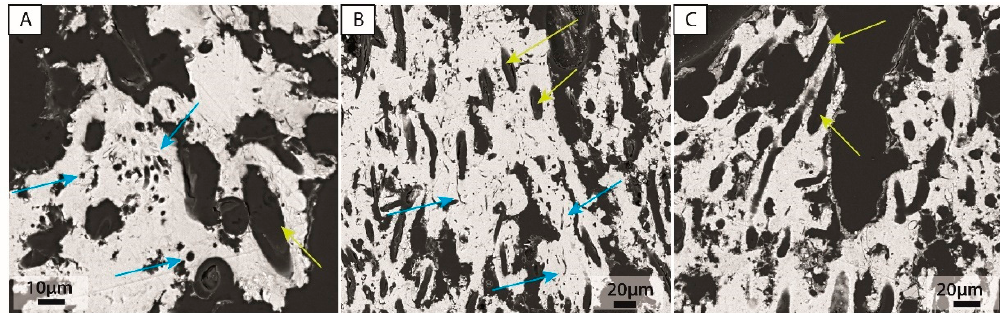
Figure 7. SEM photomicrographs of the porous dried crust thin section. ( A ) Photomicrograph showing 1 to 2- µ m-diameter rounded microstructures and other small elongated microstructures. Blue arrows indicate the small microstructures, whereas the yellow arrow points to the filament pores. ( B ) Photomicrograph showing filament remains and smaller microstructures. Blue arrows indicate the smaller microstructures, whereas yellow arrows point to the filament remains. ( C ) Photograph showing the filament remains associated with large pores. Yellow arrows indicate the pores of filament remains.